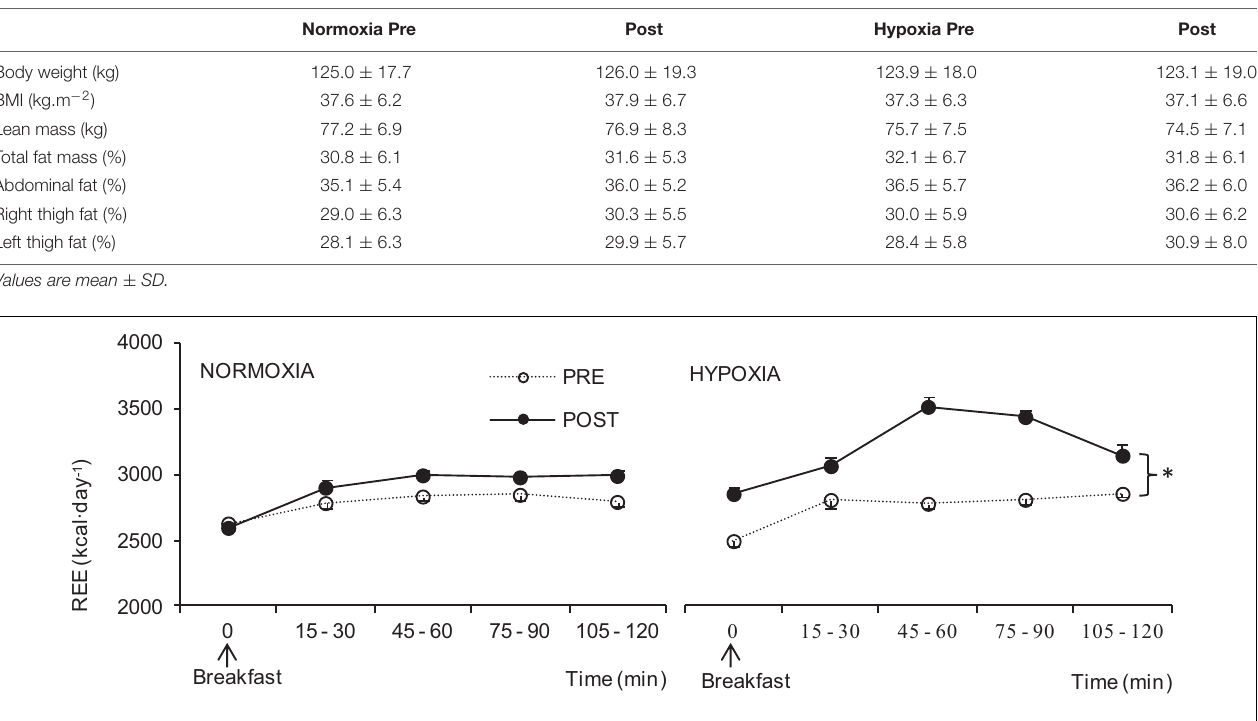
FIGURE 2 | Postprandial resting energy expenditure (REE) before (PRE), and at the end (POST) of the NORMOXIA and HYPOXIA trials. Values are mean ± SEM, n = 8. ∗ Significant differences between PRE and POST confinement; p < 0.05.